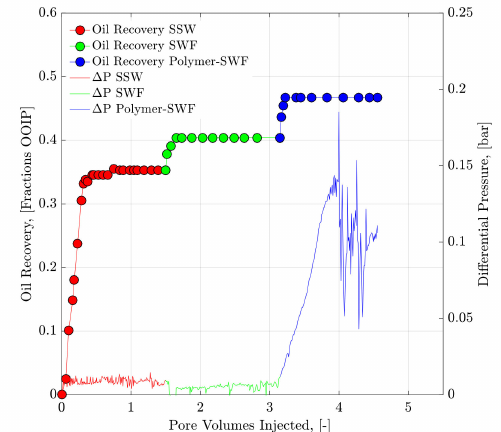
Figure 14. Oil recovery and pressure drop versus PV injected for Bent 5.4 core plug. Red color represents the experimental data for secondary-mode injection of SSW, green color is for the tertiary injection mode of smart water flood and blue color is for the post-tertiary injection mode of